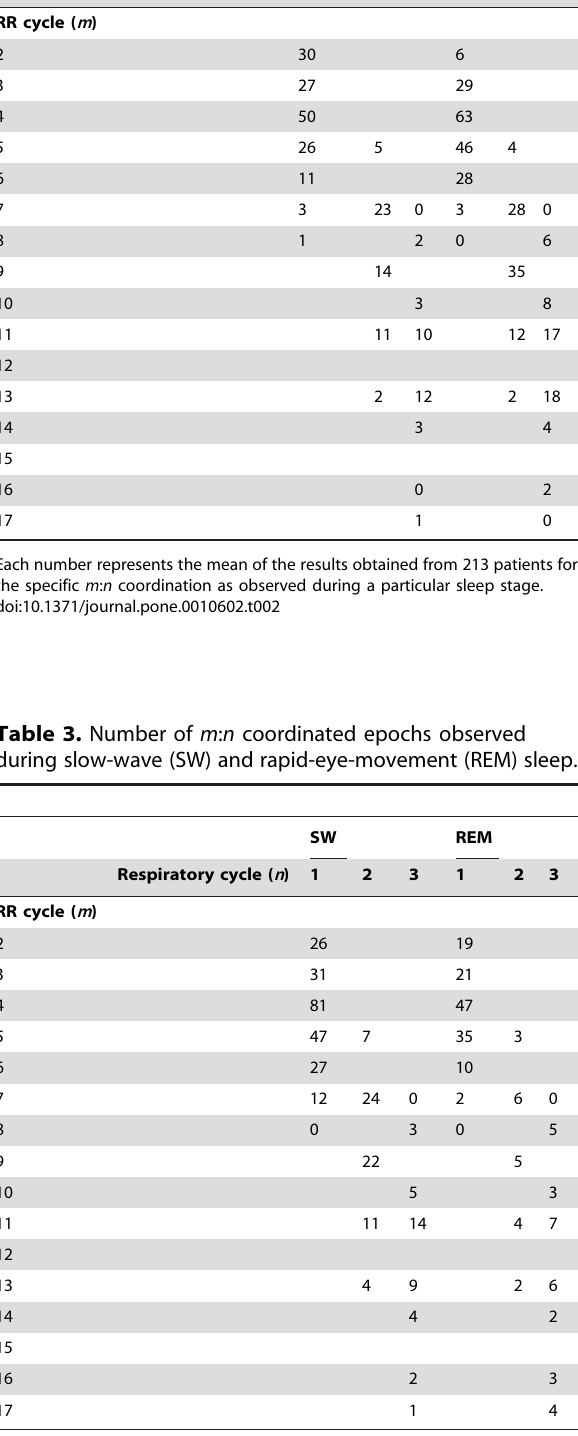
Each number represents the mean of the results obtained from 213 patients for the specific m : n coordination as observed during a particular sleep stage.